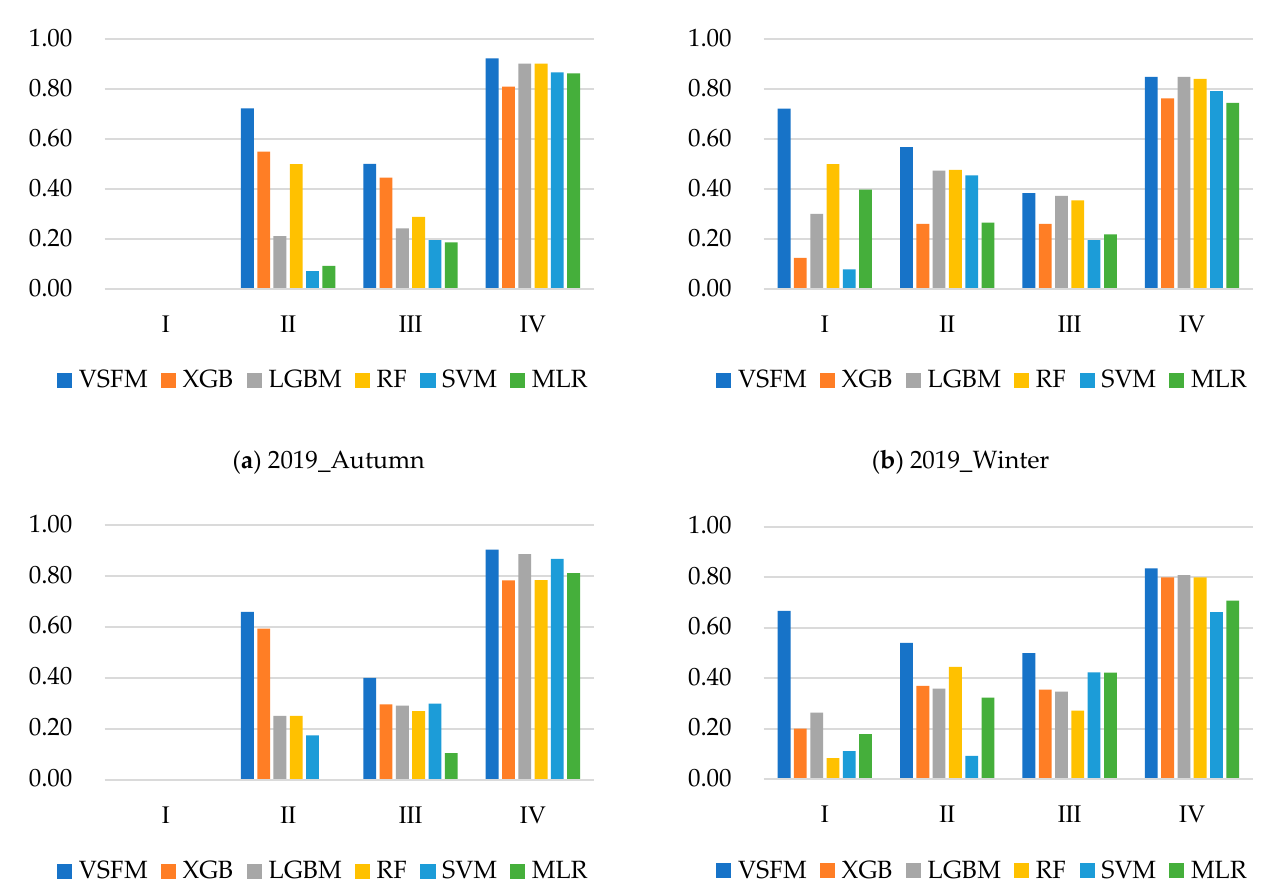
Figure 6. TS scores of several models. ( a – d ) are the TS score histograms of 2019_Autumn, 2019_Winter,